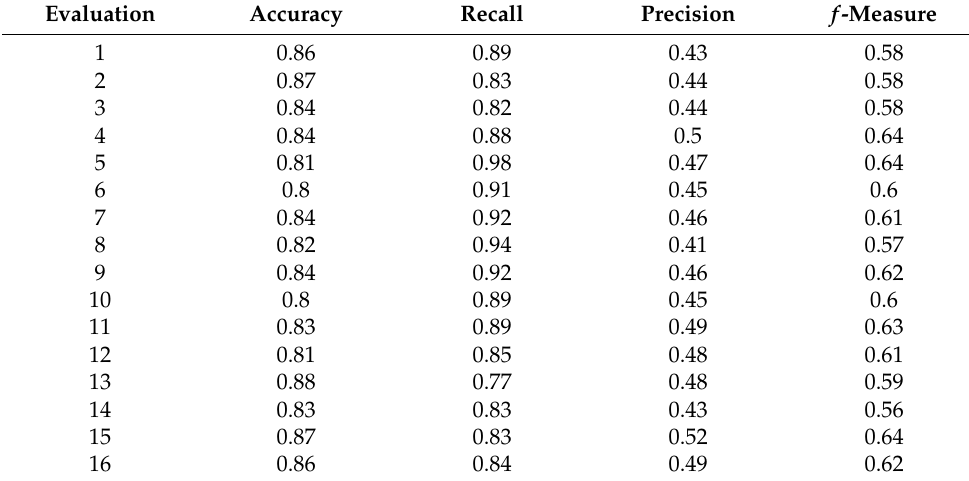
Figure 10. The outline of the proposed smartphone sensing of road surface condition. Table 1. Evaluation metrics for the proposed smartphone sensing.